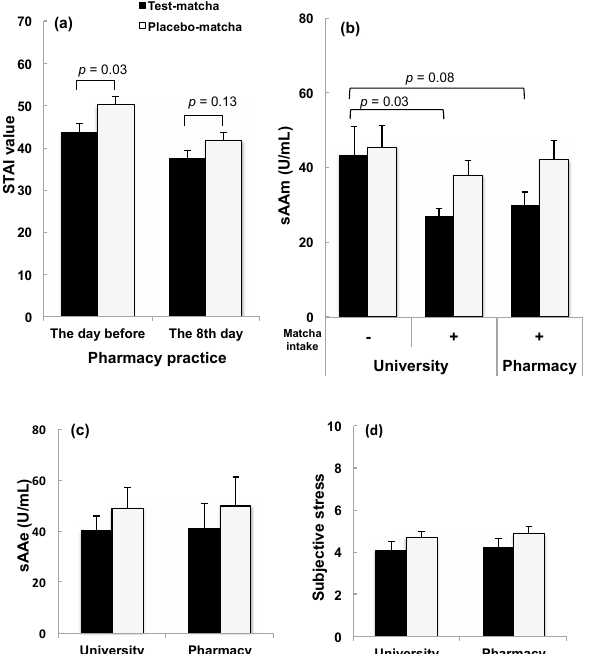
Figure 4. Effect of matcha ingestion on students during university and pharmacy practice. ( a ) The STAI test was administered before and on the eighth day of pharmacy practice. ( b , left bars) The level of sAAm was measured in participants every morning for three days during routine daily life at the university before intake of matcha as the baseline. ( b , middle and right bars) After the ingestion of matcha started, median sAAm of each participant for the last three days at the university and pharmacy practice was used for statistical analysis. The median of ( c ) sAAe and ( d ) subjective stress of each participant of the last three days at the university and pharmacy practice are shown. Each bar shows the mean ± SEM (test matcha, n = 19; placebo matcha, n = 20).